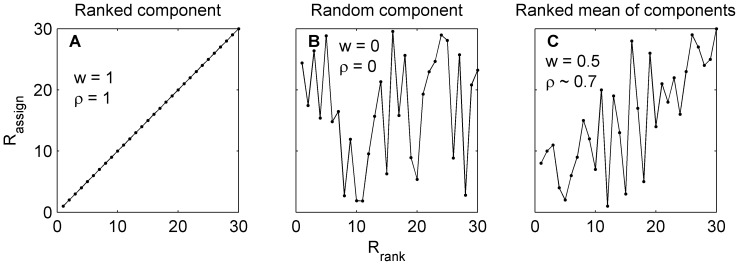
Assigning anisotropic tuning parameters based on a neuron's preferred direction.The tuning parameter value (bandwidth or peak spiking rate) given to each neuron in order of distance from cardinal may vary from being fully sorted (A) to entirely random (B). Intermediate levels of orderliness may be generated by a weighted average of the two extreme configurations by factor w; this is exemplified in (C) with w = 0.5, resulting in a rank assignment with Spearman rank correlation, ρ≈0.7.